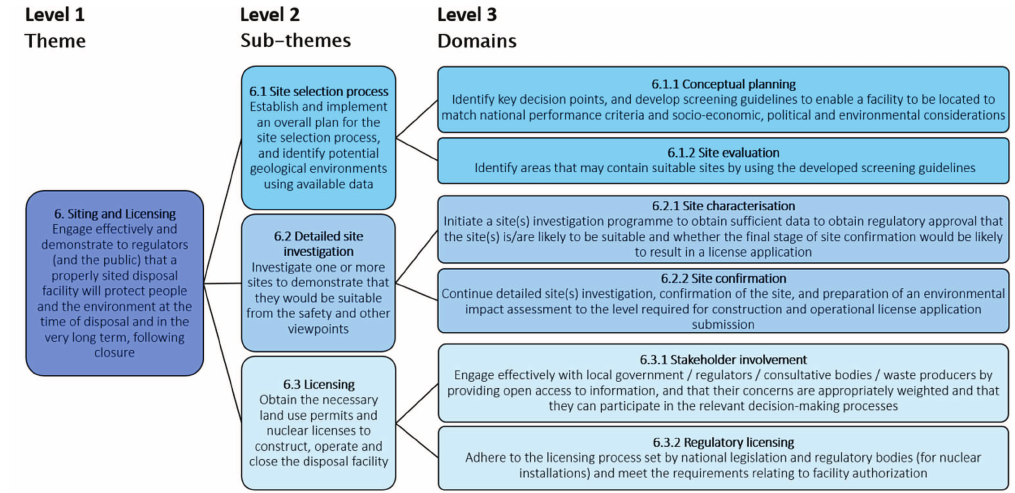
Fig. 1. Example for the breakdown of one theme (Theme 6 – Siting and Licensing) of the EURAD Goals Breakdown Structure (GBS) into the three levels (theme, sub-theme, domain) and the formulated